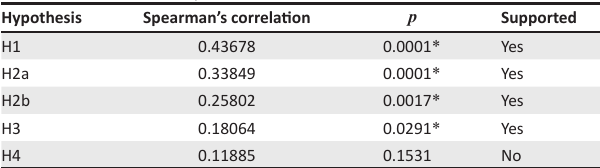
TABLE 4: Correlation analysis results. Hypothesis Spearman’s